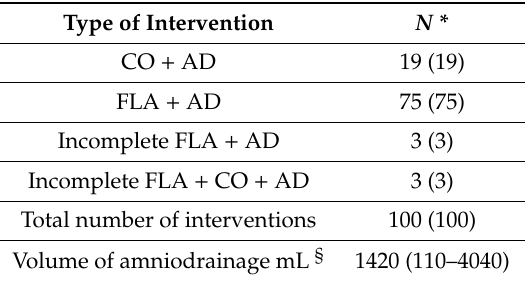
Table 2. Type of intervention and volume of amniodrainage at